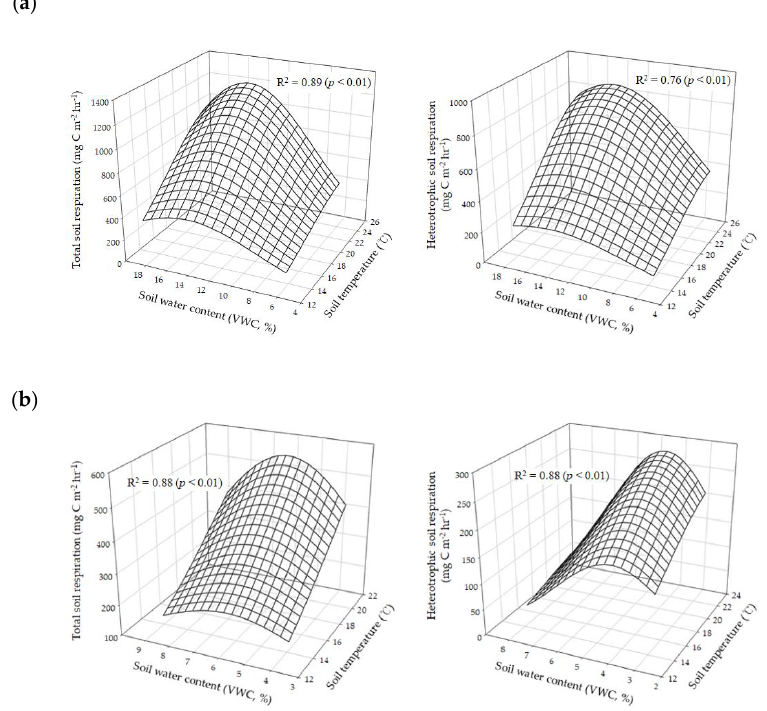
Figure 7. Combined effect of soil temperature and soil water content on the total soil respiration (SR) and heterotrophic soil respiration (HR) in ( a ) control plots and ( b ) TFE plots. R 2 is coefficient of determination and p represents p -value.